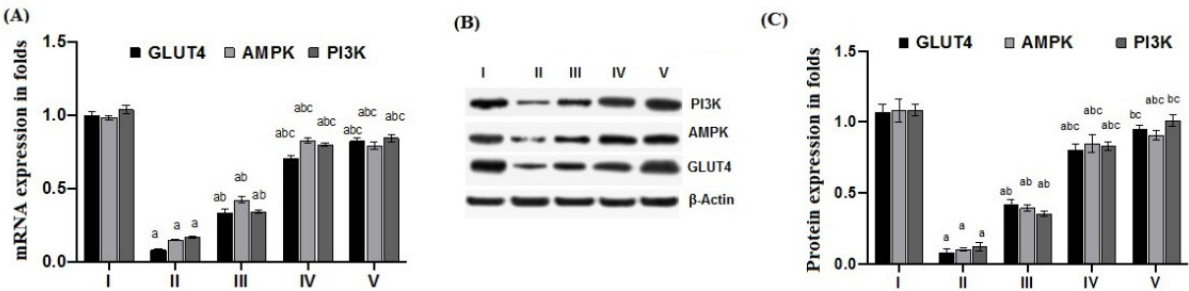
Figure 3. Effect of cichoriin on gene and protein expression of insulin sensitizing proteins in diabetic rats. Quantitative genes expression of GLUT4, AMPK, and PI3K ( A ). Quantitative analysis of affected proteins: GLUT4, AMPK, and PI3K ( B , C ). Group I (control), group II (Diabetic), group III (50 mg/kg, cichoriin), group IV (100 mg/kg, cichoriin), and group V (5 mg/kg, GB). a, b, c indicate significant difference from group I, group II and group III, respectively, at ( p ≤ 0.05). Glucose transporter type 4 (GLUT4), AMP-activated protein kinase (AMPK) and phosphatidylinositol 3-kinase (PI3K).